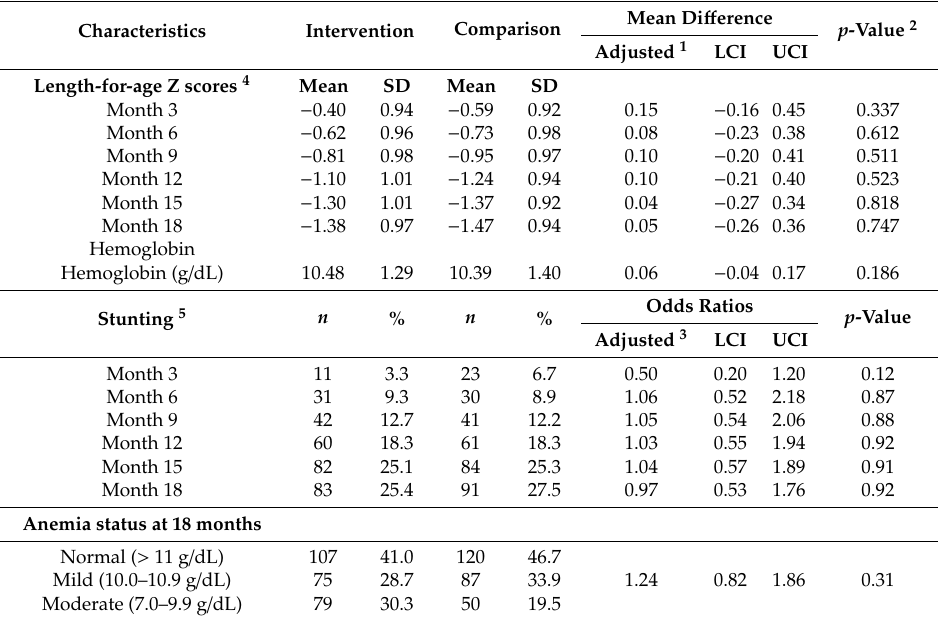
Table 6. Nutritional status of cohort children, by age and treatment